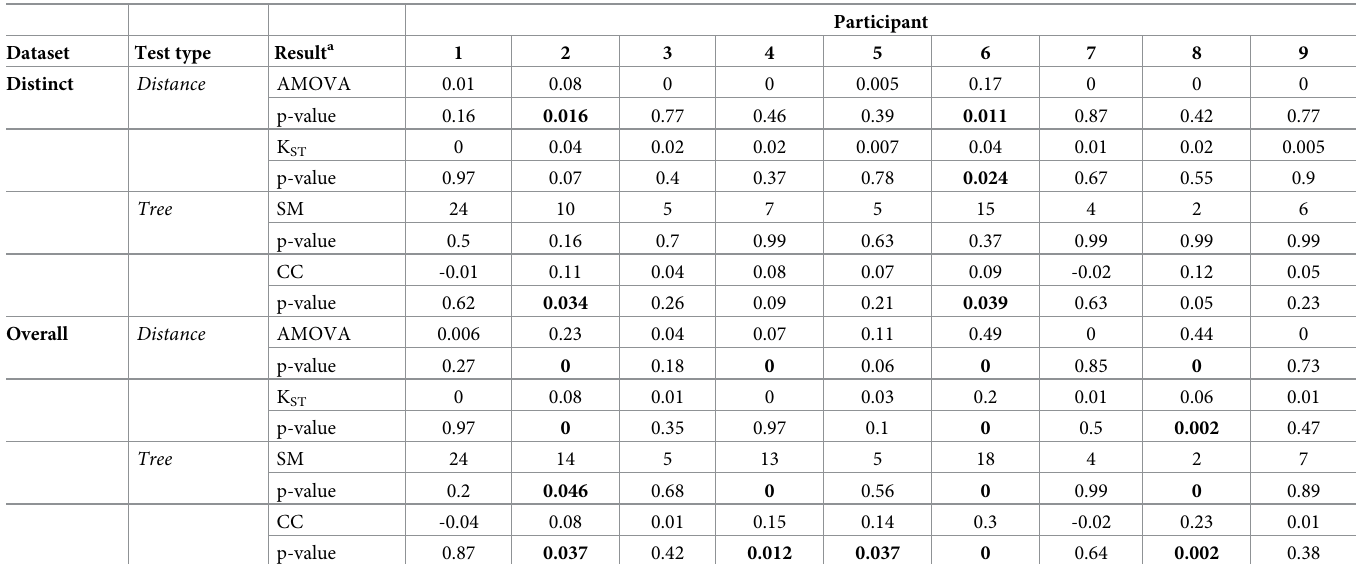
Table 2. Blood-lung compartmentalization